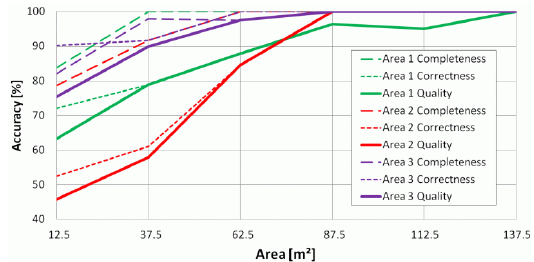
Figure 5: Evaluation of buildings on a per-object level as a func-